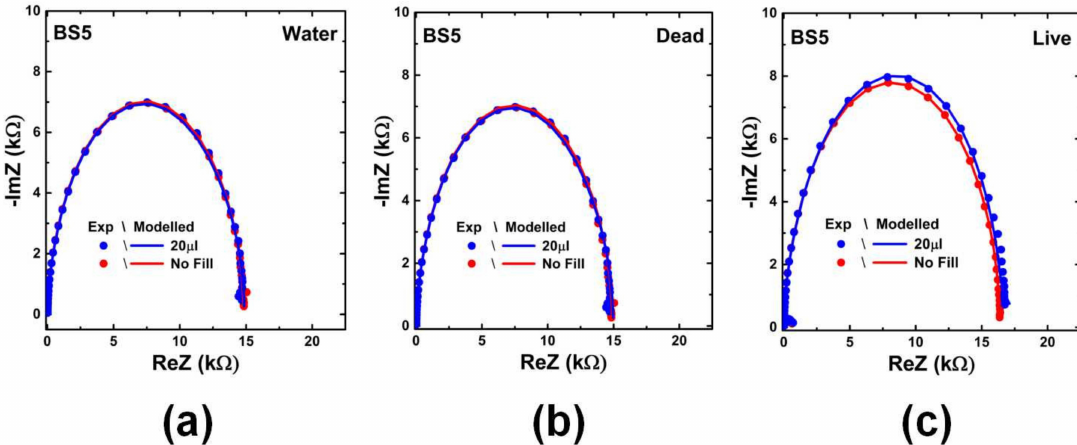
Figure A2. Measured (dotted line) and modeled (solid line) Nyquist plots of the three 1 × 1 cm 2 large impedance chip BS5 ( a ) with No fill condition and ( b ) with addition of 20 µ L Dl water used to investigate impedance changes by adding 1, 2, 3, 4, and 5 µ L DI water ( a ) without cells, ( b ) with dead cells, and ( c ) with live cells. Modeled parameter values from equivalent circuit model shown in Figure 6b are listed in Table A2. The impedance parameters of the 1 × 1 cm 2 large impedance chips BS5 used to investigate impedance changes by adding 1, 2, 3, 4, and 5 µ L DI water without cells ( a ), with dead cells ( b ) are similar and there is very minute change below 100 Hz. This minute change can be seen in the fitting parameters (C Au/liq , R Au/liq ) (Table A2). The comparison of the modeled equivalent circuit parameters (No Fill and 20 µ L DI) reveals that for the BS5 chips (DI water, Dead) R j changed (Table A2) and for the BS5 chip (Live) C j and R p+n changed (Table